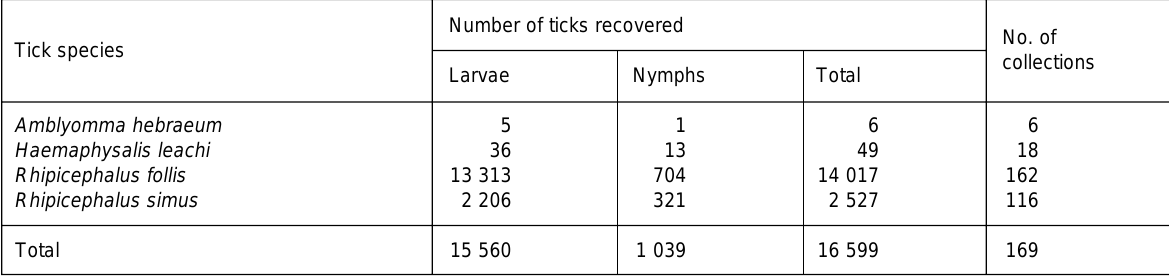
TABLE 1 Ixodid ticks in 172 collections from striped mice in the Thomas Baines Nature Reserve Number of ticks